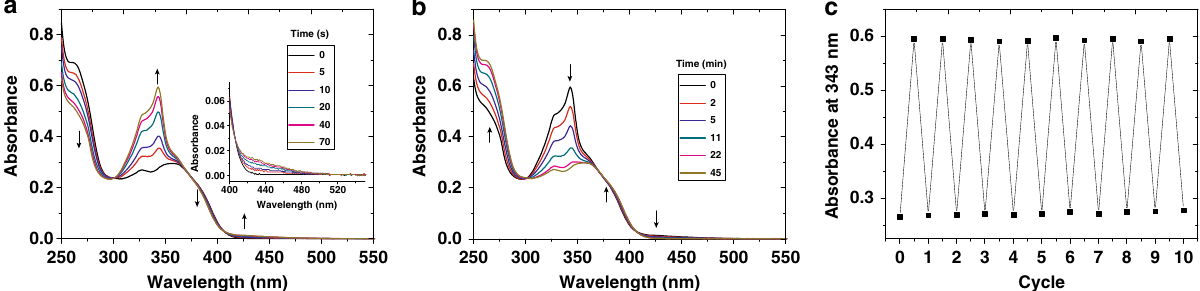
Fig. 6 Photo- and thermal-isomerization monitored by absorption spectra. Absorption of 3b a upon UV irradiation 365 nm and b then heated at 55 °C (CHCl 3 , 2.24 × 10 -5 M); c absorbance at 343 nm upon UV irradiation at 365 nm for 70 s and then heated at 55 °C for 45 min in repeated cycles.